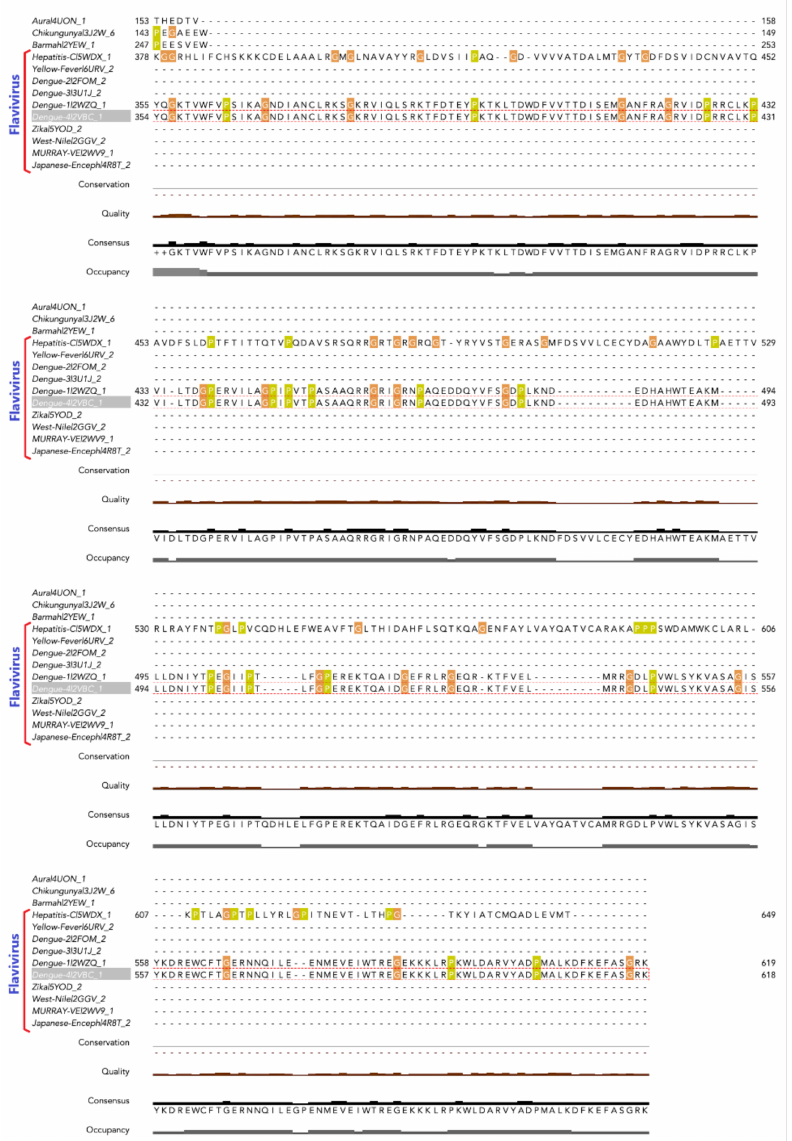
Figure A1. Multiple Sequence Alignment of Flavivirus Family. Dengue viruses (all four serotypes), hepatitis C virus, yellow fever virus, zika virus, West Nile virus, Murray Valley encephalitis, and Japanese encephalitis are all members of the Flavivirus family. Aura virus, Chikungunya virus, and Barmah virus (carried by mosquitoes but not of the Flavivirus family) are included for comparison. The Flavivirus family shows a high homology degree, especially in the regions flanking S137 indicated by the red box and text. The degree of homology is less in the other proposed phosphorylation sites T180, S244, S271, and T